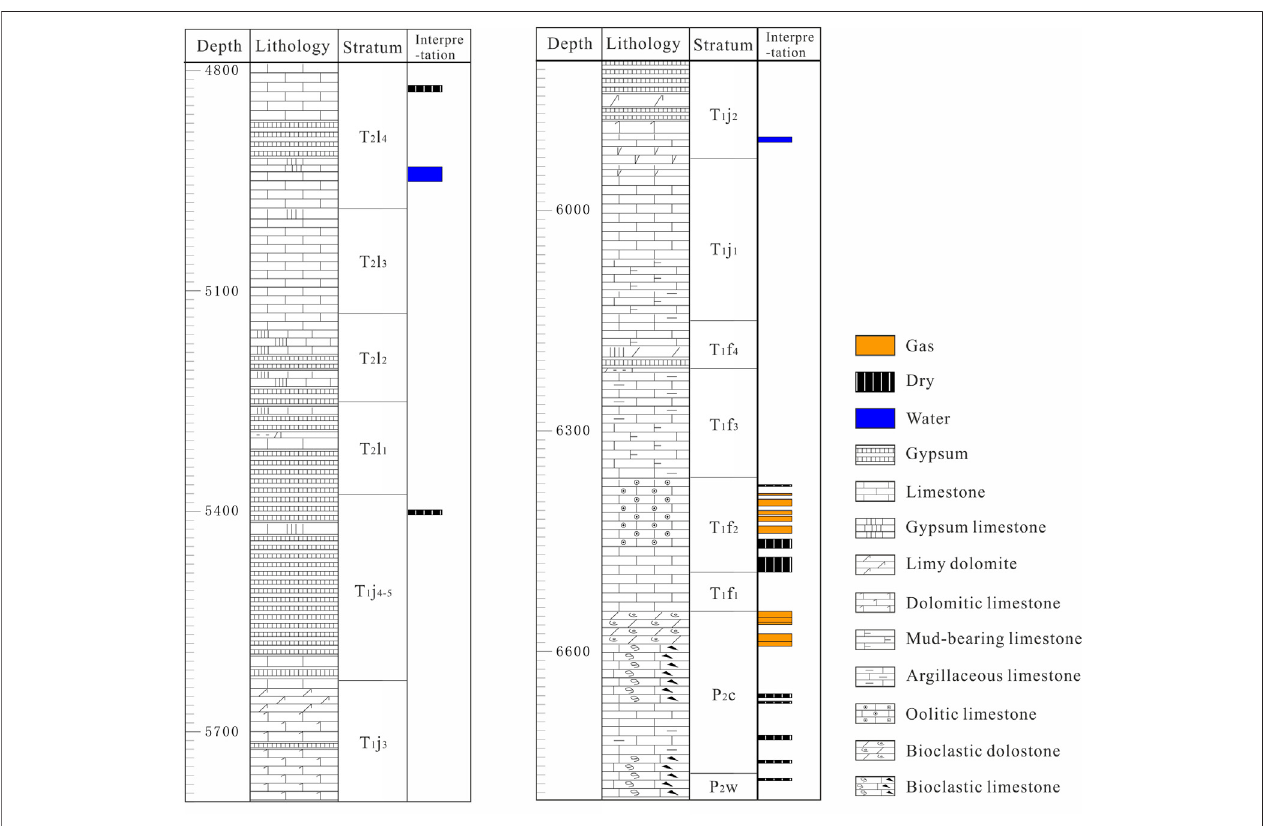
FIGURE 4 | Lithology distribution and gas distribution of